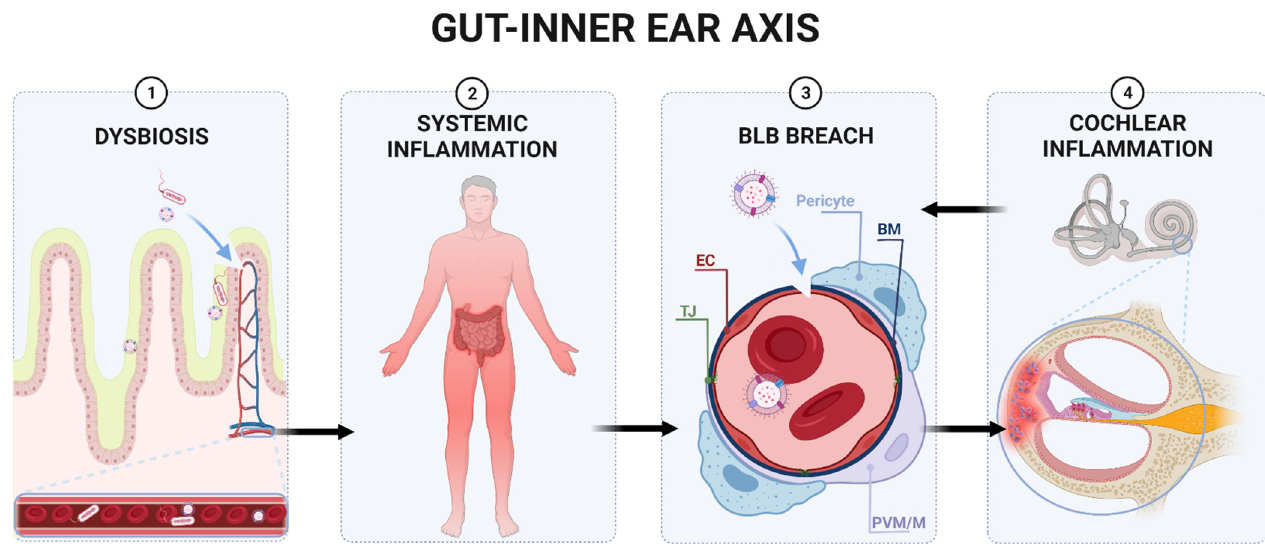
Figure 1. Proposed gut–inner ear axis resulting in sensorineural hearing loss (SNHL). ( 1 ) Gut dysbiosis induced by a high-fat diet can damage the intestinal barrier and cause a leaky gut. ( 2 ) This allows gut microbiota and bacterial toxins such as lipopolysaccharide to infiltrate the bloodstream and cause a systemic inflammatory response. ( 3 ) Pathogens and inflammatory cytokines reaching the inner ear can damage the blood–labyrinth barrier (BLB). ( 4 ) Infiltration of pathogens to the inner ear leads to the activation of resident macrophages, the release of pro-inflammatory cytokines, and the overproduction of reactive oxygen species (ROS), causing apoptosis of damaged cells and immune cell infiltration in the lateral wall of the cochlea (spiral ligament and stria vascularis). Inflammatory processes in the cochlea might further increase the BLB’s permeability, perpetuating inflammation. Unresolved inflammation leads to damage of sensorineural structures, eventually causing SNHL. Abbreviations: EC, endothelial cell; TJ, tight junction; BM, basement membrane; PVM/M, perivascular-resident macrophage-like melanocytes.